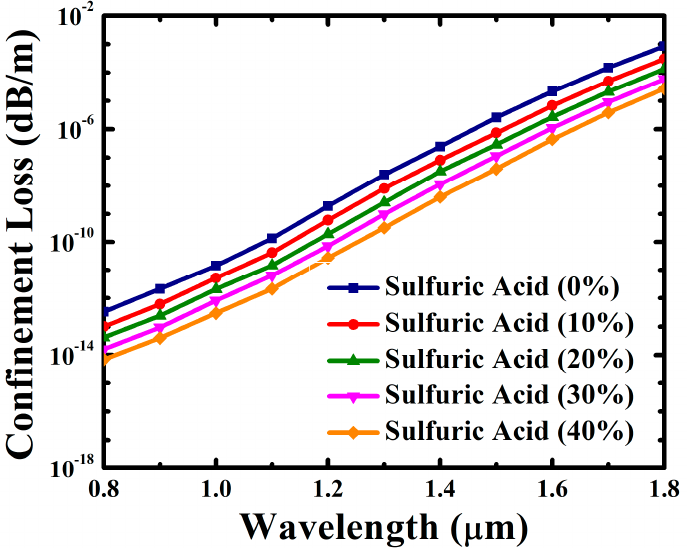
Figure 6. Confinement loss of the proposed PCF sensor with 0%, 10%, 20%, 30%, and 40% concentrations of sulfuric acid for different operating wavelengths.